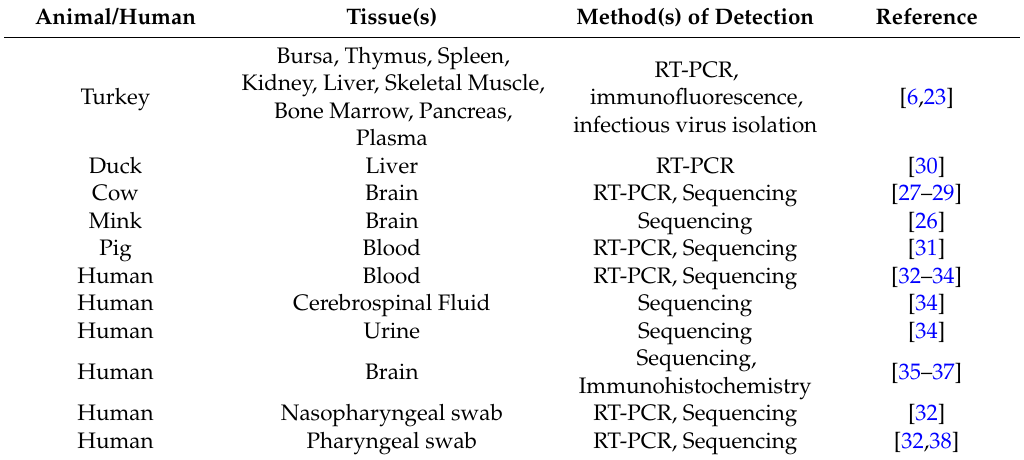
Table 1. Astrovirus localization in extra-intestinal